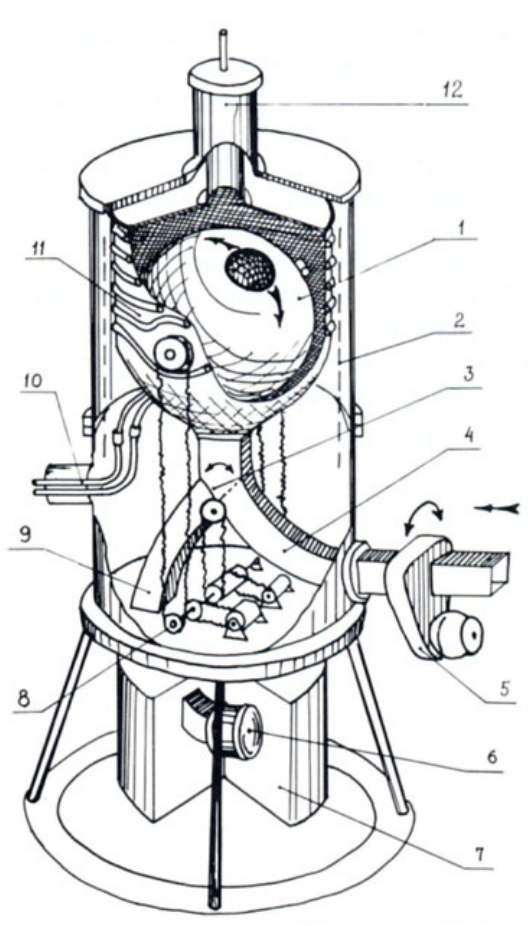
Figure 5. The original Gravitrap neutron lifetime bottle apparatus [38]: (1) UCN storage bottle; (2) liquid nitrogen screen; (3) neutron distribution valve; (4) neutron guide; (5) neutron filling valve; (6) 3 He neutron counter; (7) radiation shielding; (8) rotational control linkage; (9) neutron guide; (10) cryogen lines; (11) cryostat; (12) frozen oxygen